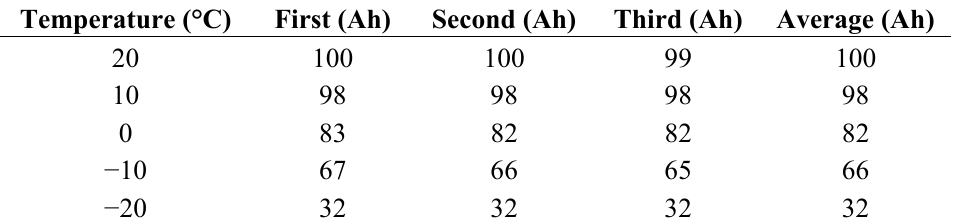
Table 1. Available capacity at different